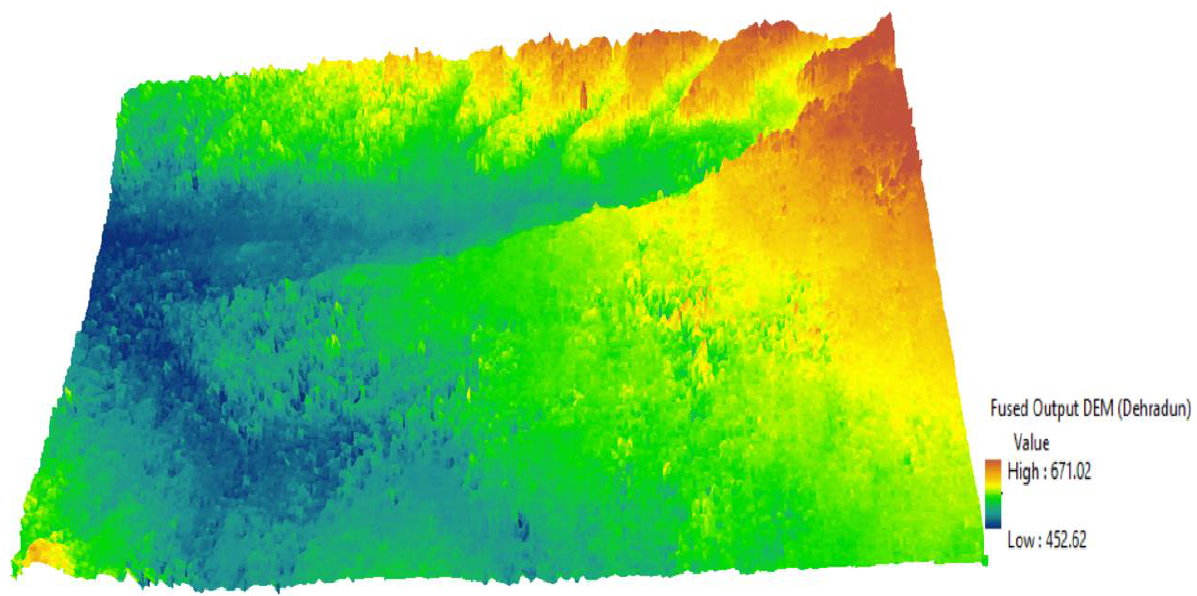
Figure 8. Fused Output DEM obtained from Neural Network-based fusion approach for Dehradun and surrounding regions.